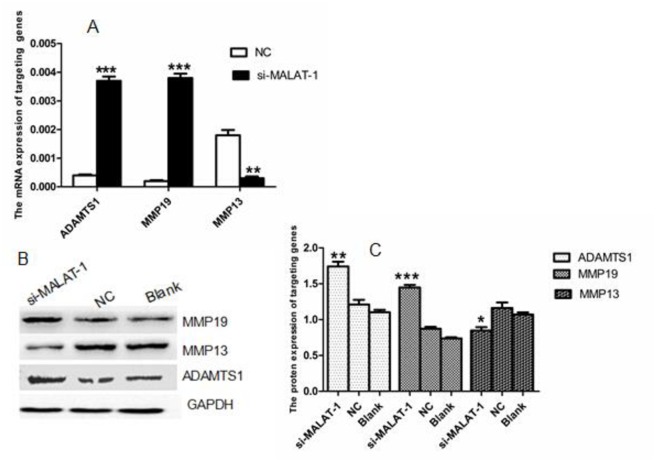
Extracellular matrix proteins are regulated by MALAT-1.(A) mRNA expression of ADAMTS1, MMP13, and MMP19 are regulated by MALAT-1. *p<0.05 versus control groups. (B)ADAMTS1, MMP13, and MMP19 protein expression are altered as a result of MALAT-1 knockdown. (C) Quantification of B. *p < 0.05 versus the control.